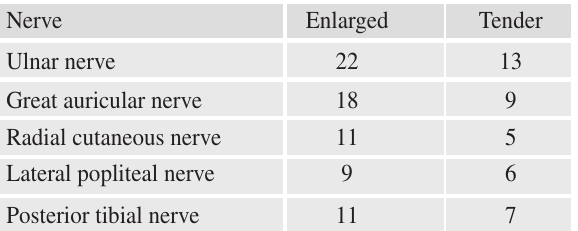
Table IV: Involvement of nerves in leprosy !